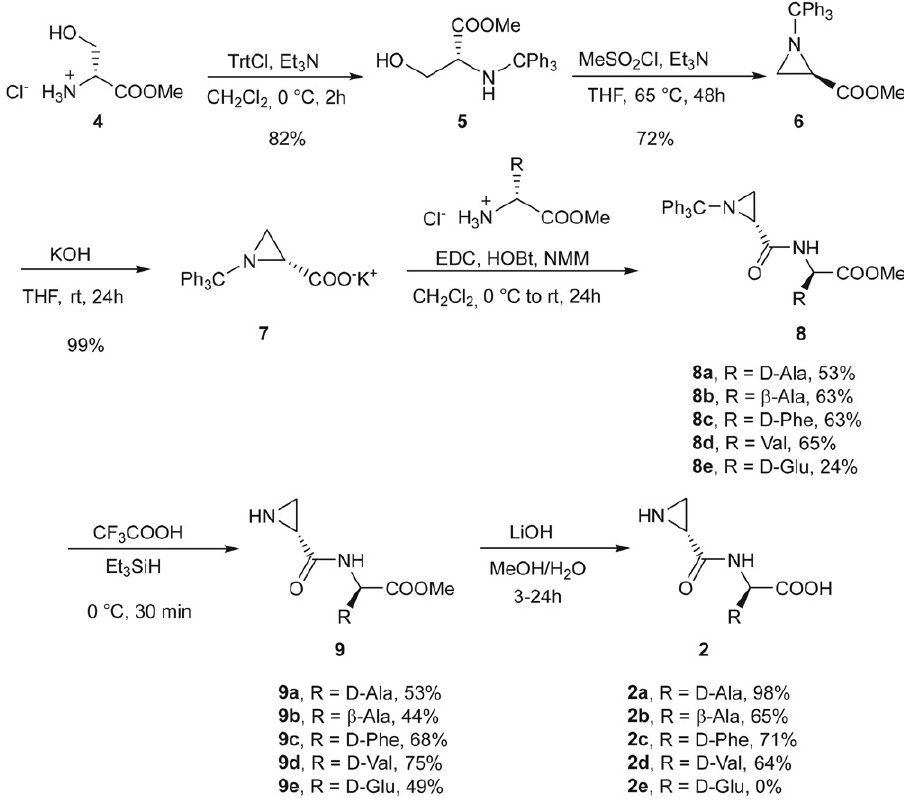
Figure 3. Synthesis of aziridine containing dipeptides.